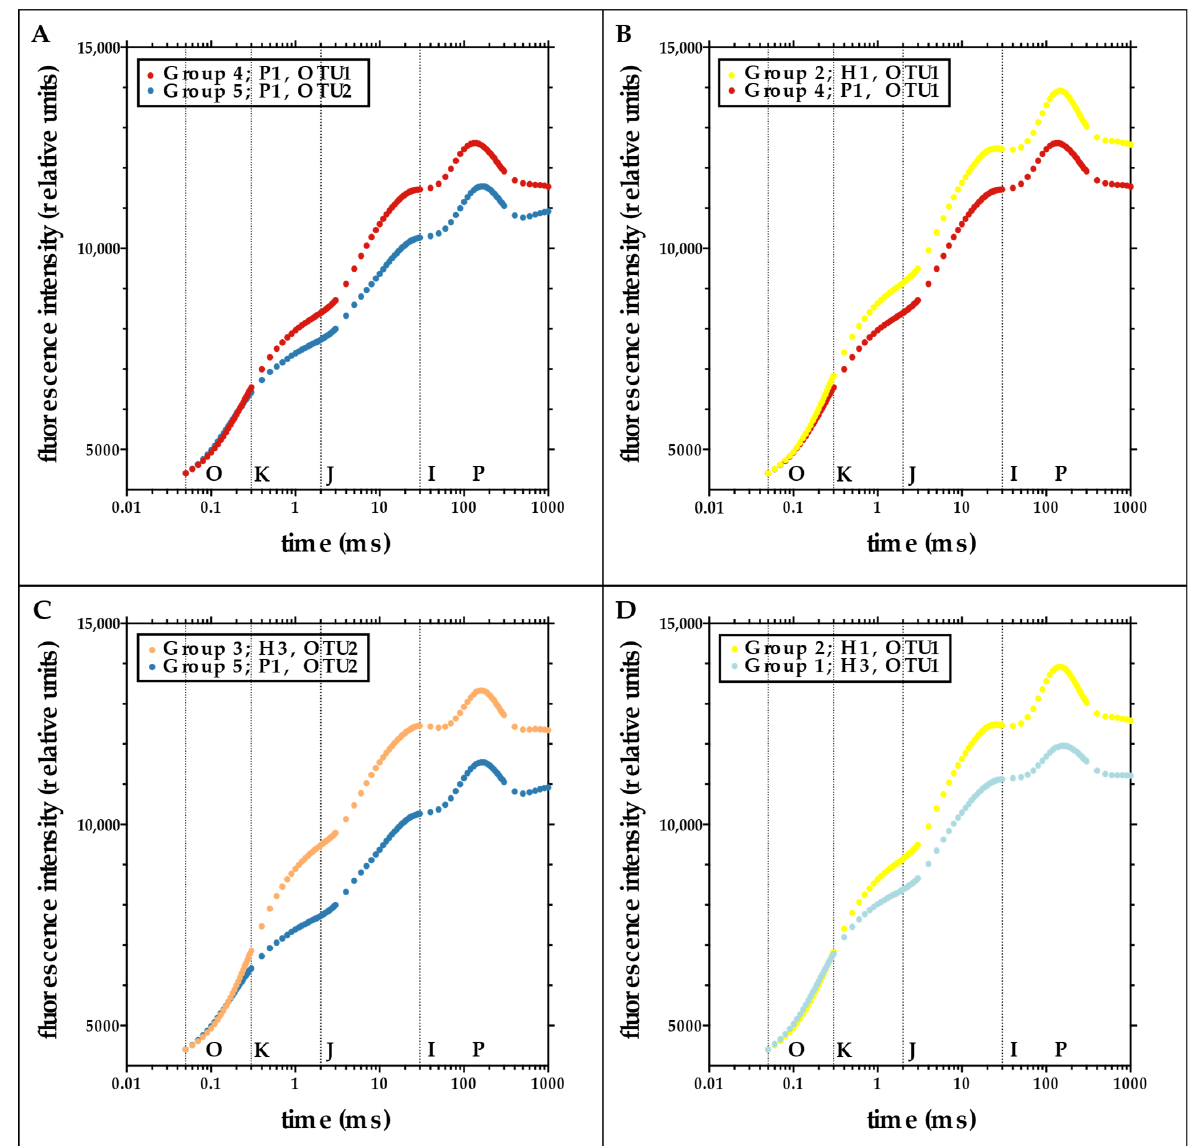
Figure 1. Effect of different algae ( A ), different fungal species ( B , C ), and different intraspecific